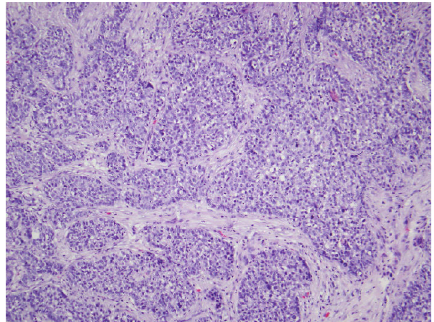
Figure 4: Tumor cells with clear cytoplasm with morphology and immunophenotype consistent with sebaceous carcinoma. H&E original magnification ×